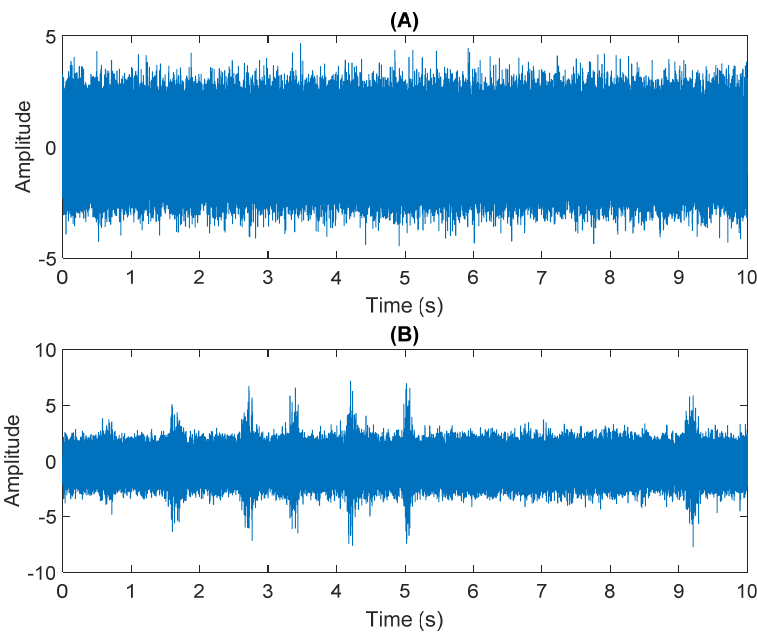
Figure 24. Analysis of data separated by ICA: ( A ) white Gaussian noise; ( B ) mixed sources.